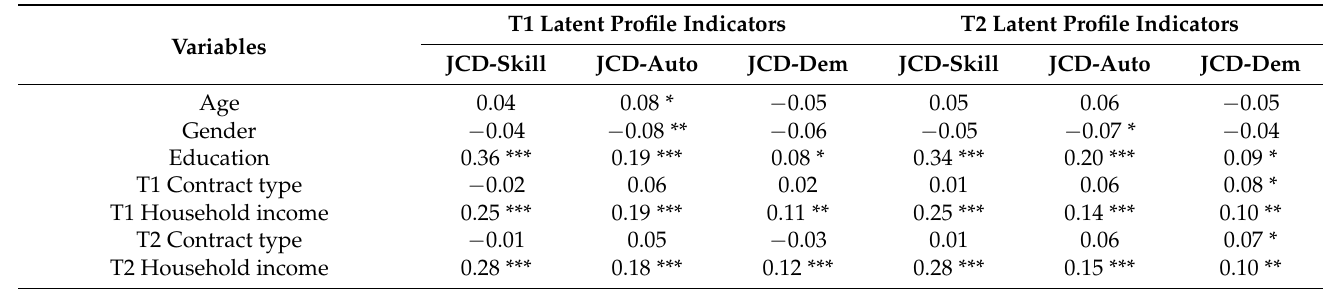
Table A1. Correlations between demographic variables and latent profile indicators.